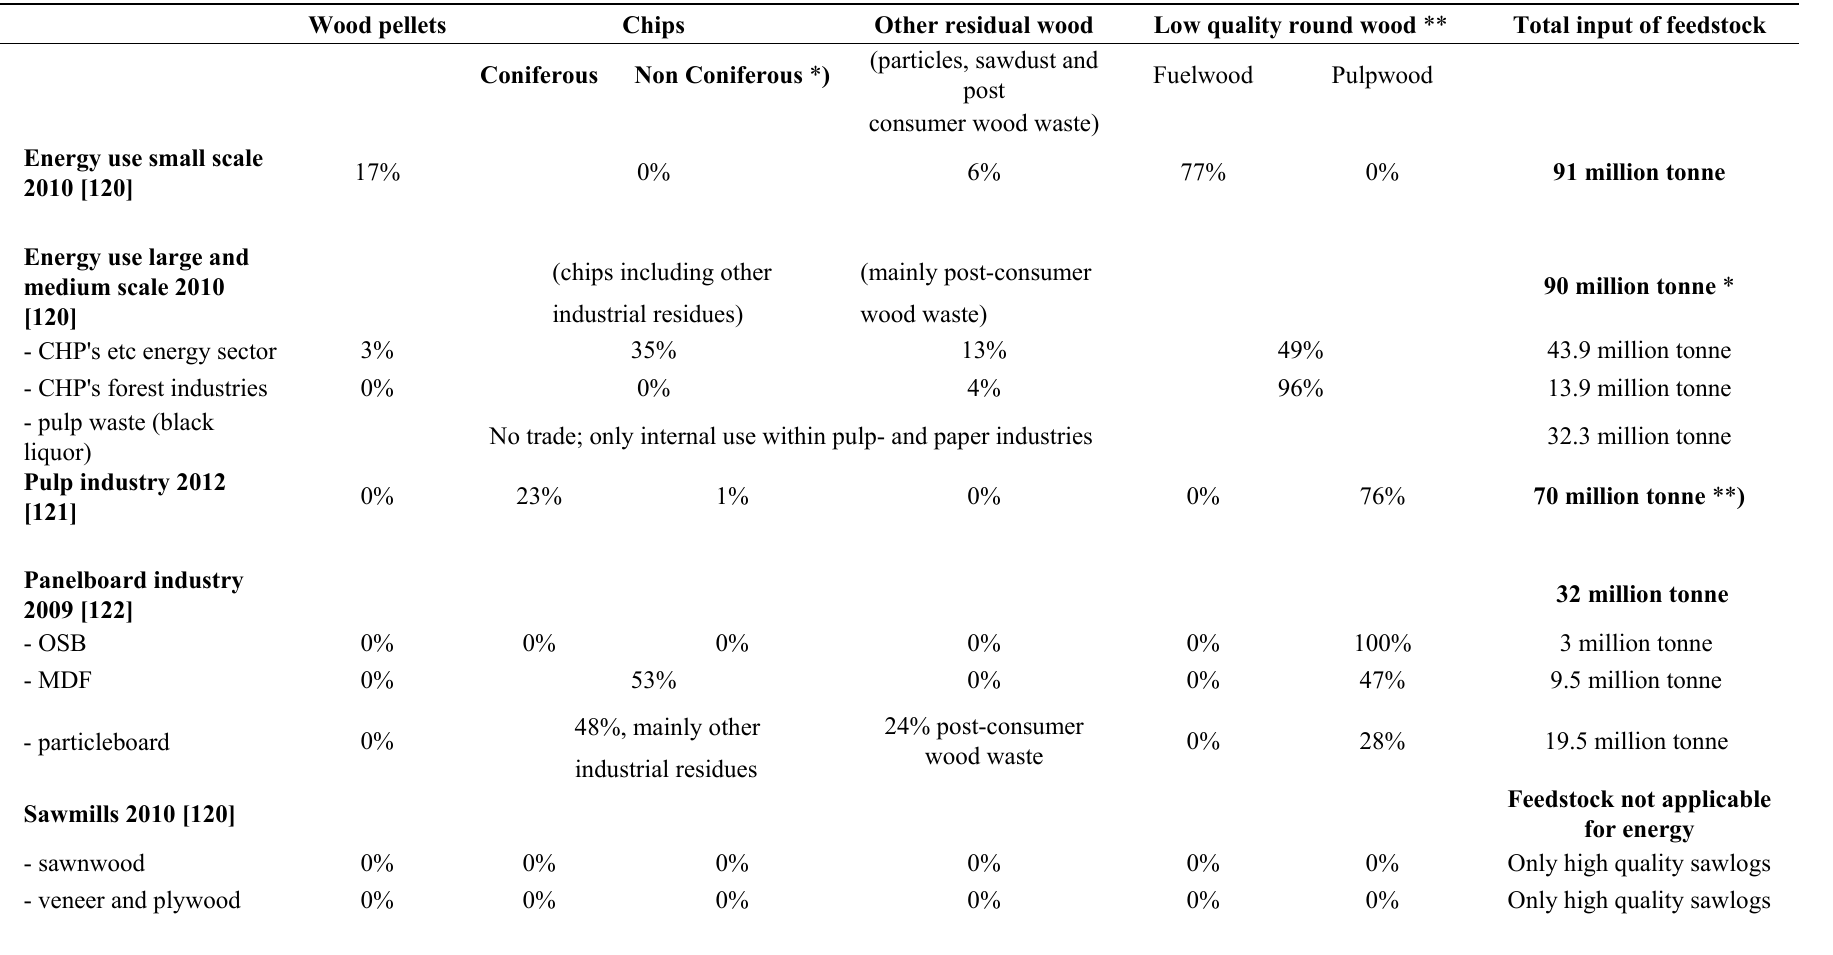
Table A1. The division of different woody feedstock use for energy (in % of total) per sector [120–122]. Forest sector’s internal use is covered in Sector 2. Conversion of energy use categories about 0.54 tonne per m 3 feedstock [120], and of pulp industry about 0.475 tonne per m 3